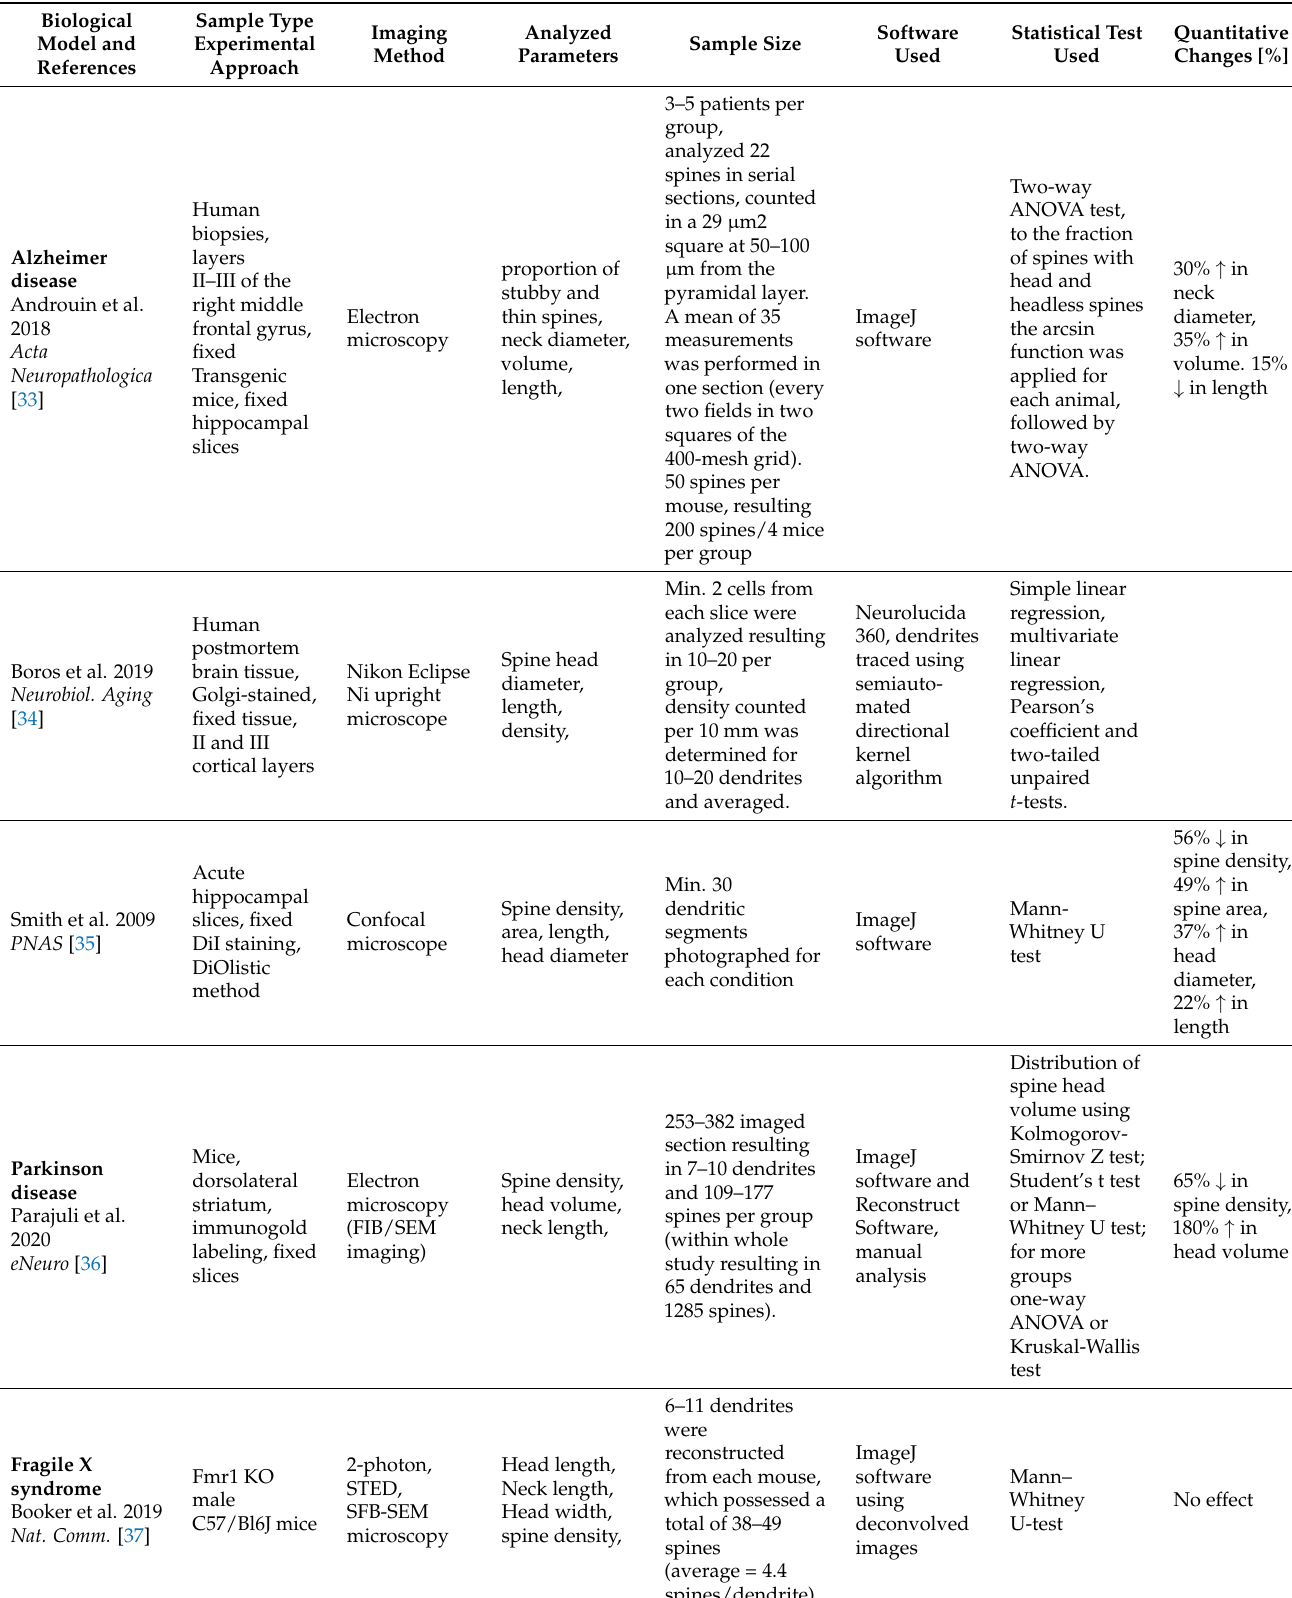
Table 2. The experiments assessing the morphology and remodeling of dendritic spines in brain diseases. The arrows indicate an increase ( ↑ ) or a decrease ( ↓ ) of measured